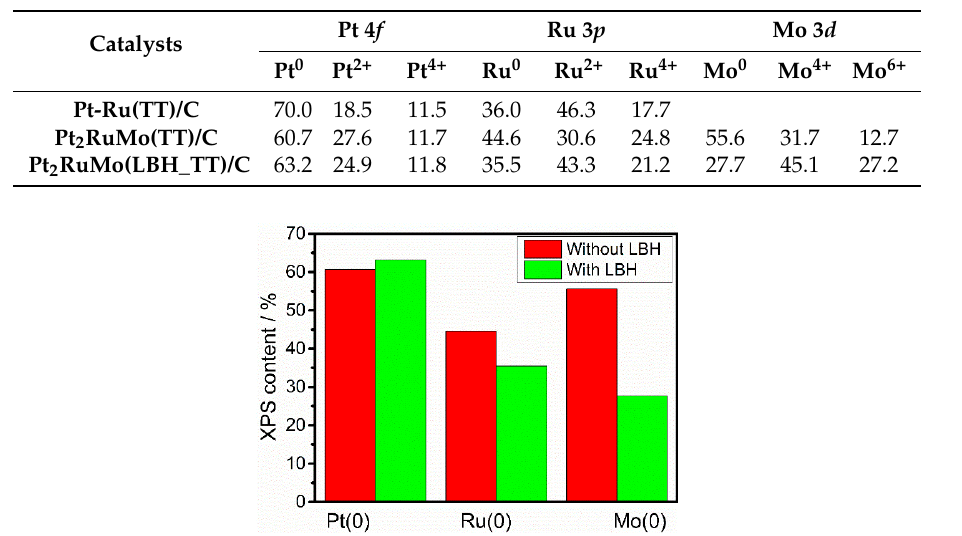
Figure 4. Histogram of the amount of Pt(0), Ru(0) and Mo(0) in Pt 2 RuMo(TT)/C and Pt 2 RuMo(LBH_TT)/C catalysts by XPS measurements.